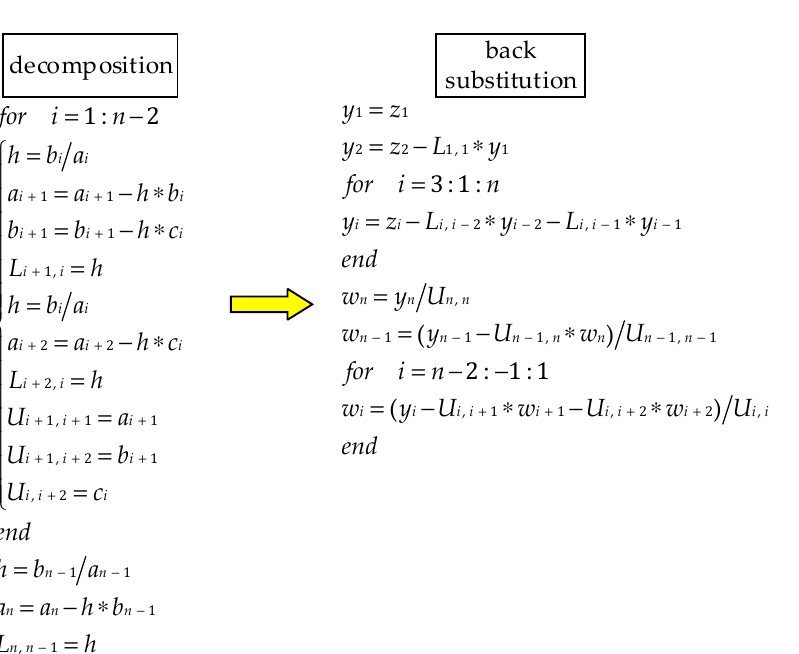
Figure 7. Flow chart of LU decomposition method.